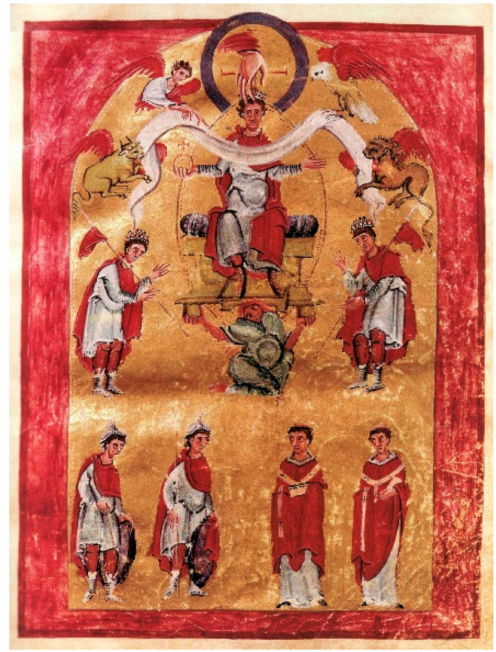
Figure 2. Otto III in Glory , illumination, 983–1000. Aachen, Domschatzkammer, Inv. Grimme Nr. 25,